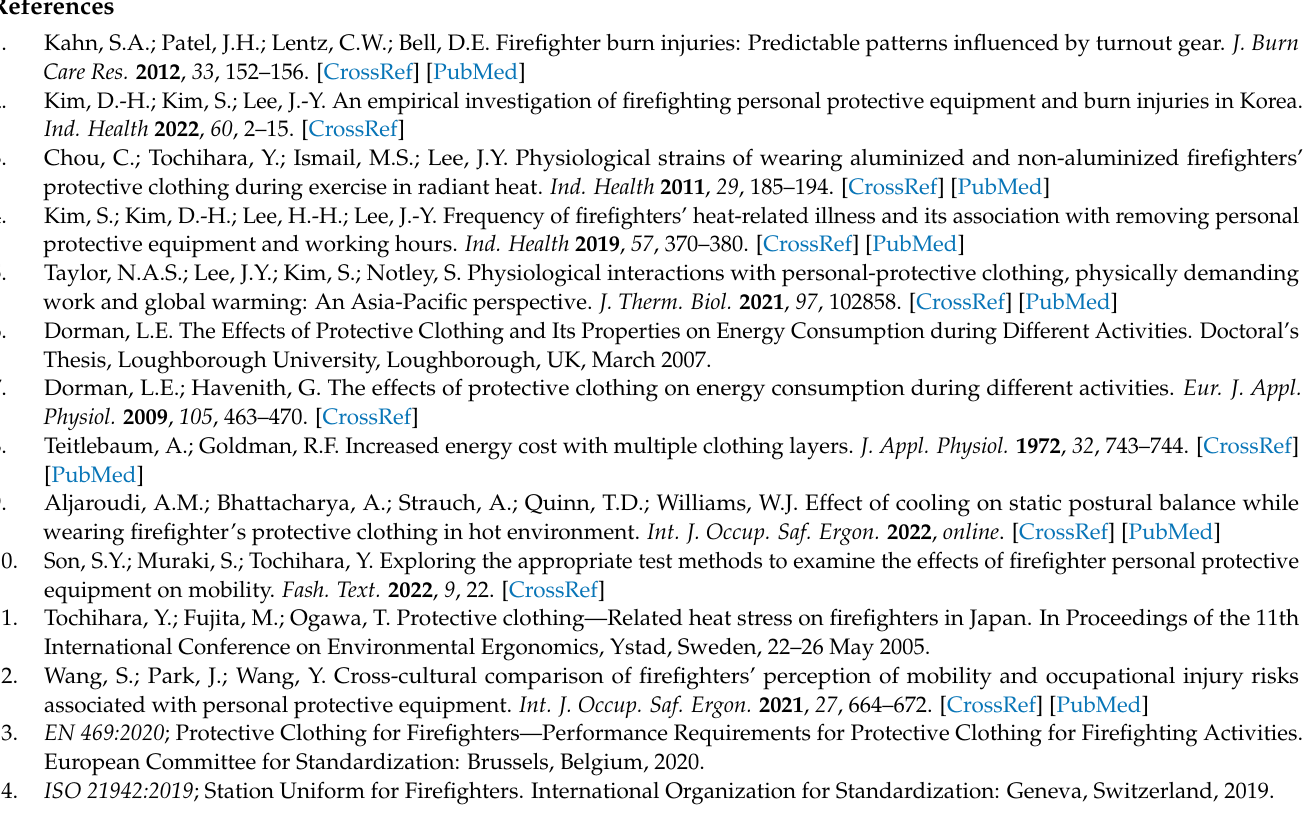
Figure A3. Uncorrected total evaporative resistances (Ret,raw), and according to Wang et al. [98], corrected total (Ret) and clothing (Recl) evaporative resistances of the tested clothing ensembles (m 2 Pa/W). For clothing combination descriptions, see Tables 1–3.